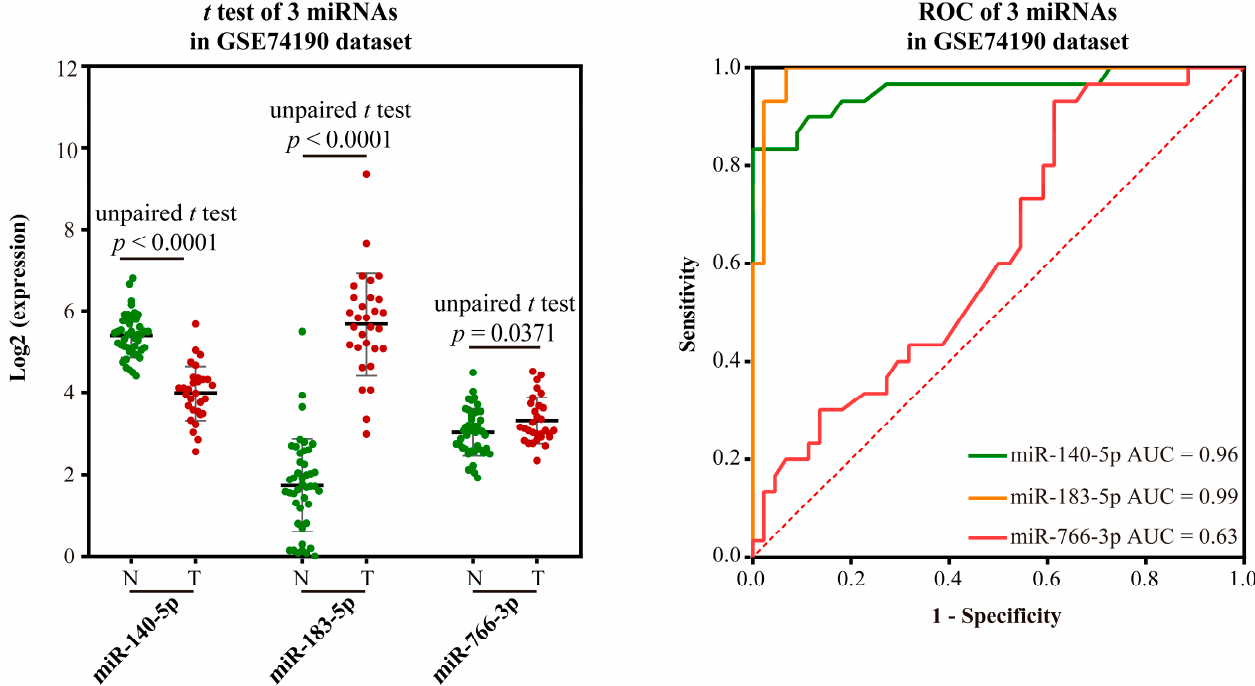
Figure 6. Validation results of 3 miRNA markers in LUSC in GSE74190 dataset. The green dot indicates the normal sample, while the red dot indicates the tumor sample.